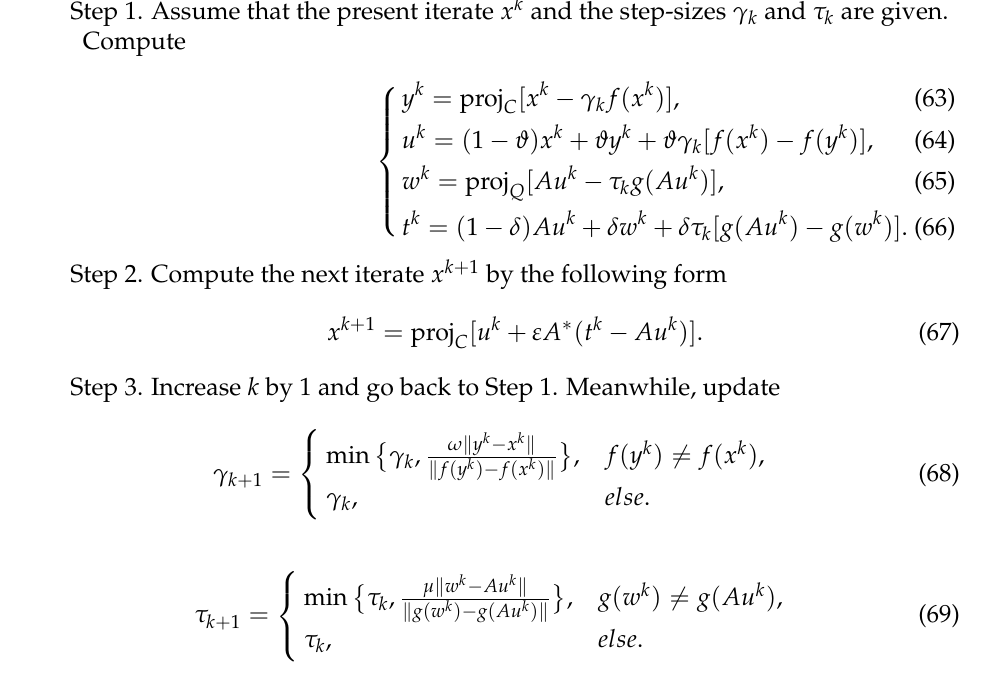
Algorithm 2: Select an initial point x 0 ∈ C . Set k =